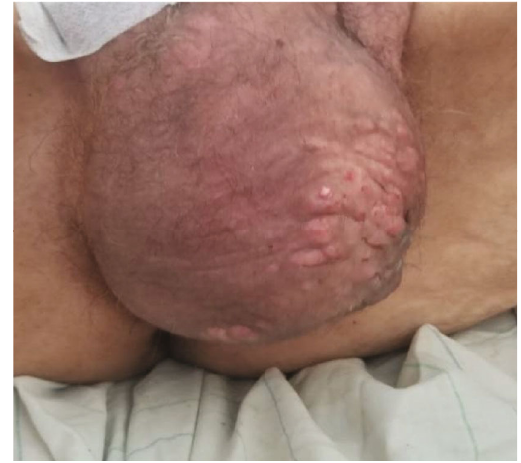
Figure 6: Regression of skin nodules after hormone